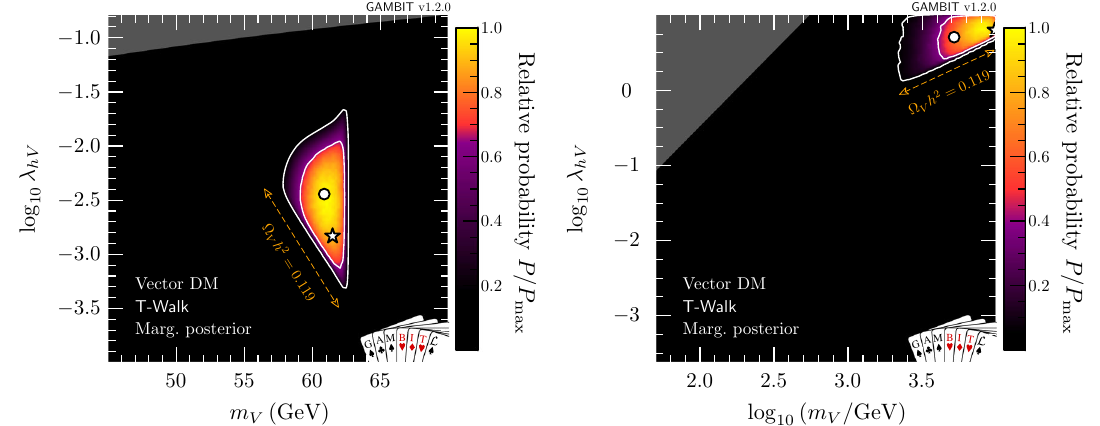
Fig. 7 Marginalised posterior distributions in the ( m V ,λ hV ) plane for vector DM. Contour lines show the 1 and 2 σ credible regions. The left panel gives the result of a scan restricted to the resonance region around m V ∼ m h / 2. The right panel shows a full-range parameter scan. The low-mass mode is sufficiently disfavoured in the full-range scan that it does not appear in the righthand panel. The greyed out region shows